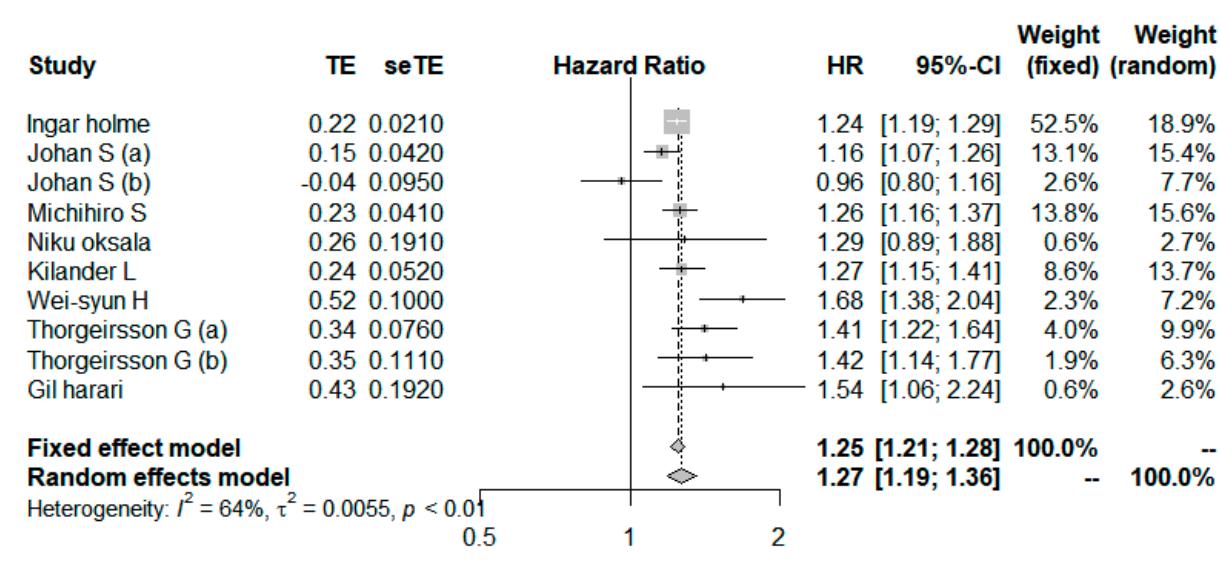
Figure 3. Forest plot for pooled HRs and 95% CIs of CVD mortality for highest versus lowest categories of Serum Total cholesterol (TC) level [23–25,27,28,31–33]. The overall effect was obtained from a random-effect model.